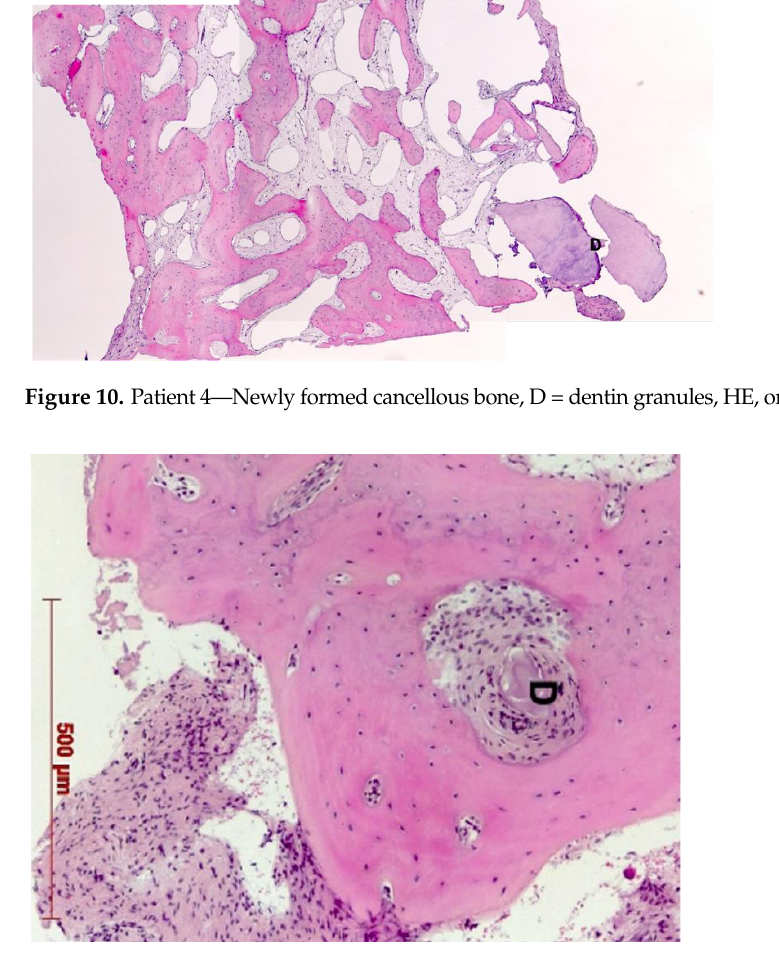
Figure 11. Patient 5—Early-stage osteogenesis around dentin granule (D), HE, original magnification ×